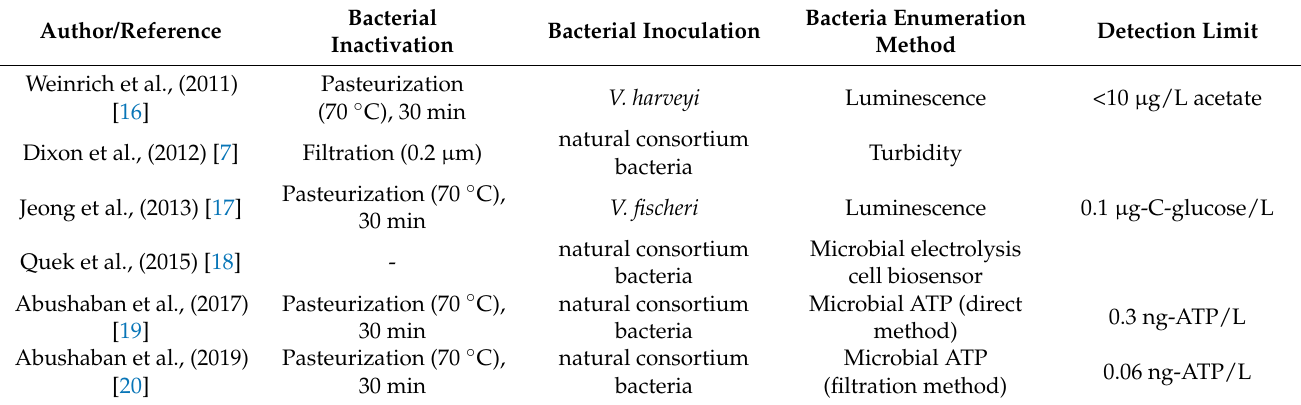
Table 1. Bacterial growth potential methods for seawater